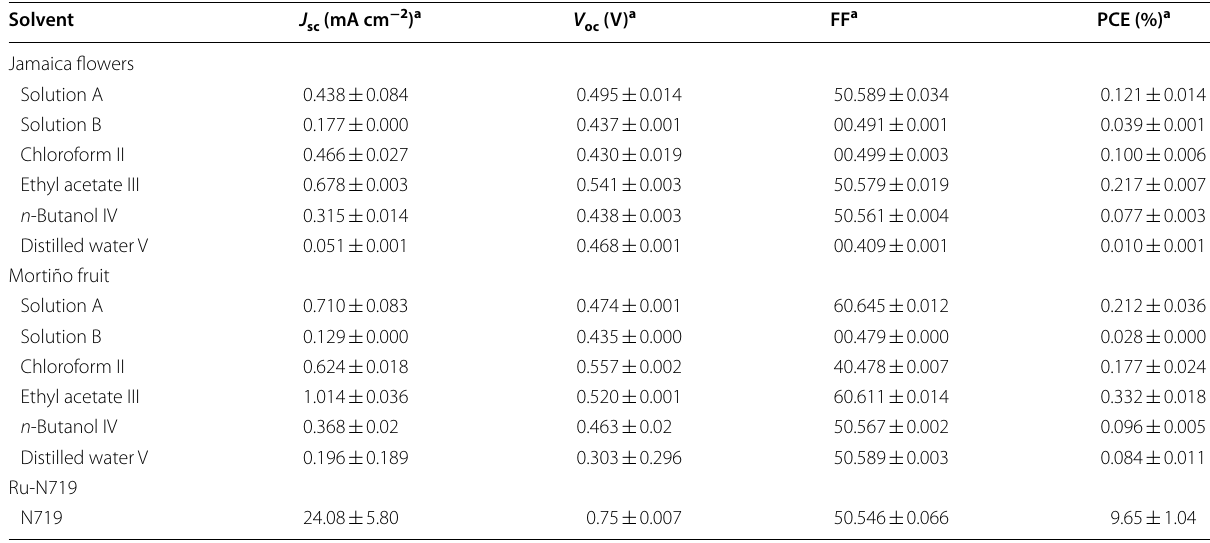
Table 3 Photoelectrochemical parameters of DSSCs using extracts purified with different solvents from Jamaica flowers and Mortiño fruit as